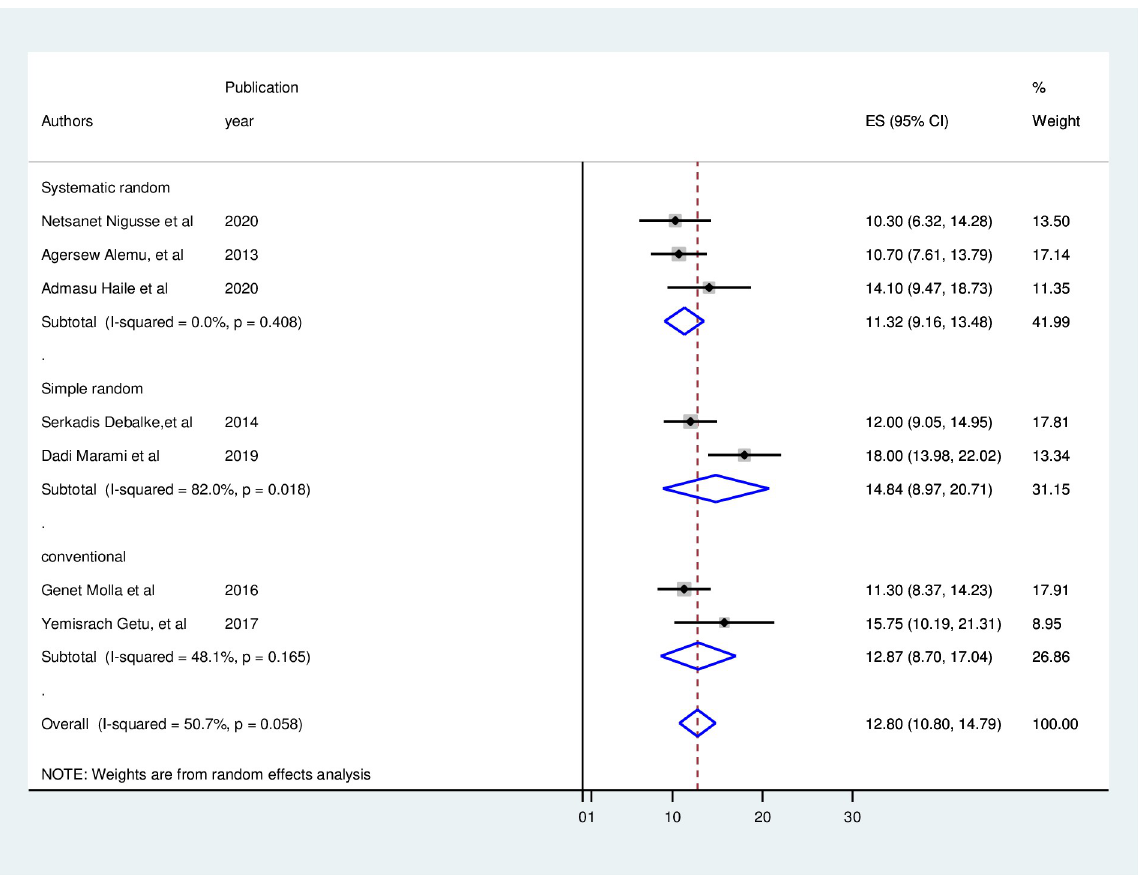
Fig 4. Subgroup analysis over sampling method.